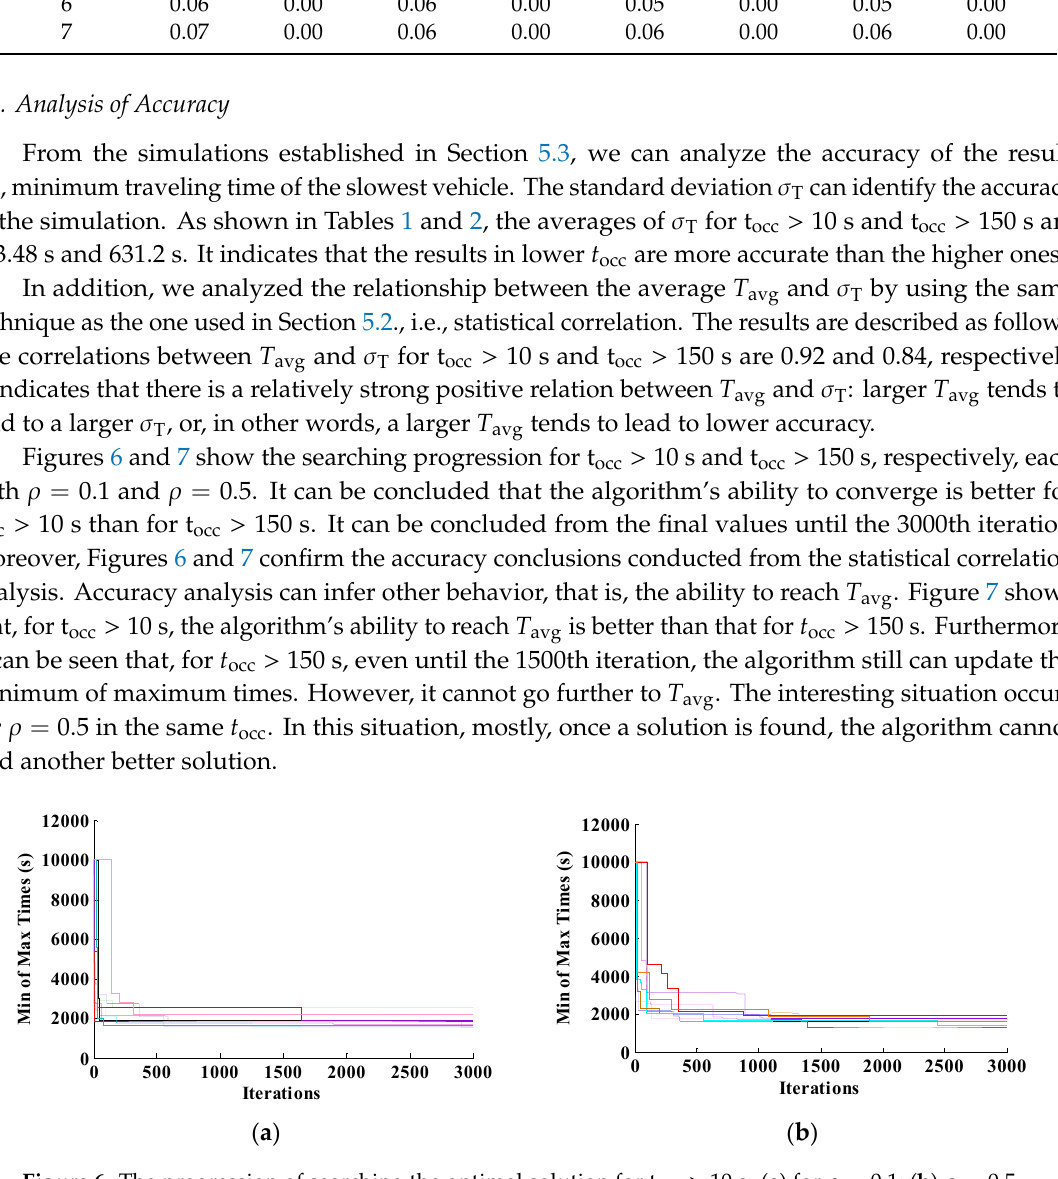
Figure 6. The progression of searching the optimal solution for t occ > 10 s: ( a ) for ρ = 0.1; ( b ) ρ = 0.5 .